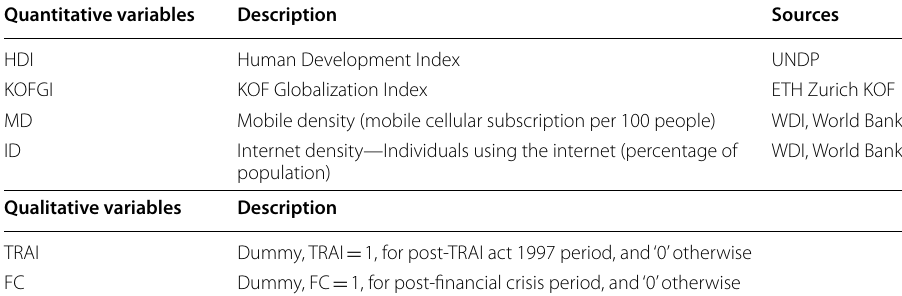
Table 2 Data sources and variables